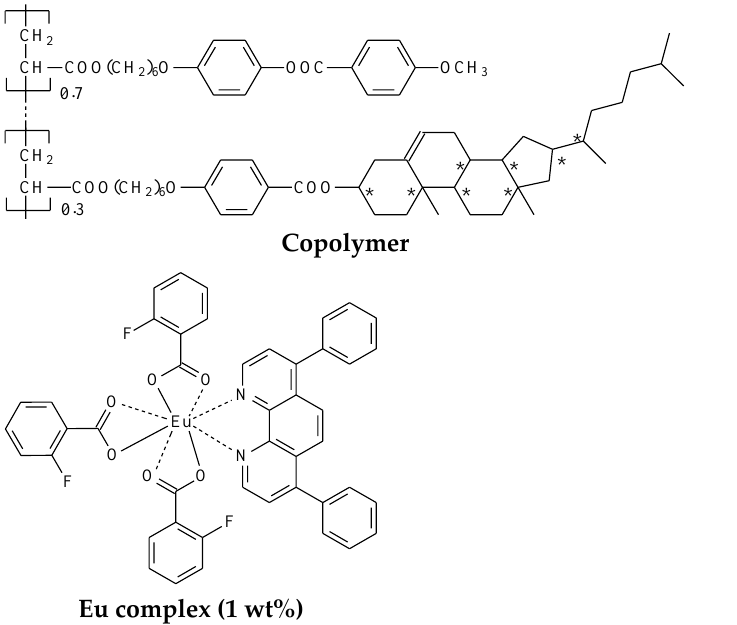
Figure 1. Chemical structures of the cholesteric copolymer and the Eu complex used for mixture preparation.